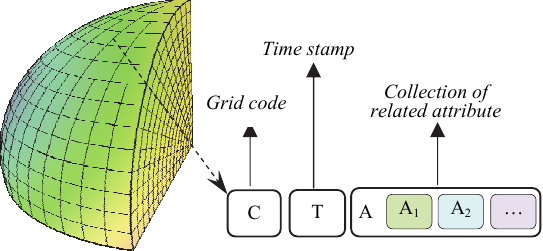
Figure 6 The CTA triple model for spatial data representation and